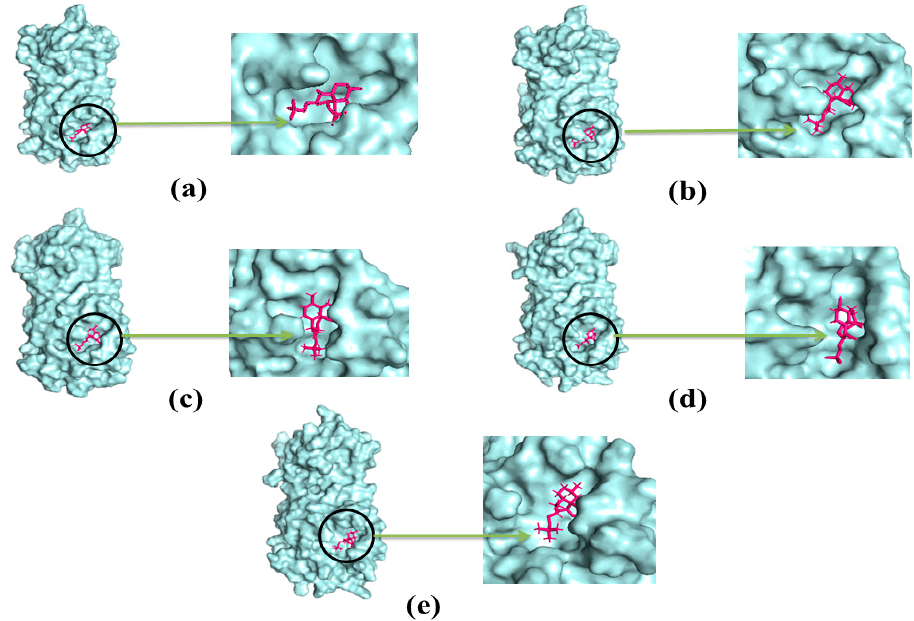
Figure 9. The dynamics snapshots ( a – e ) of phenethyl alcohol and main protease complex after 0, 25, 50, 75, and 100 ns, respectively.